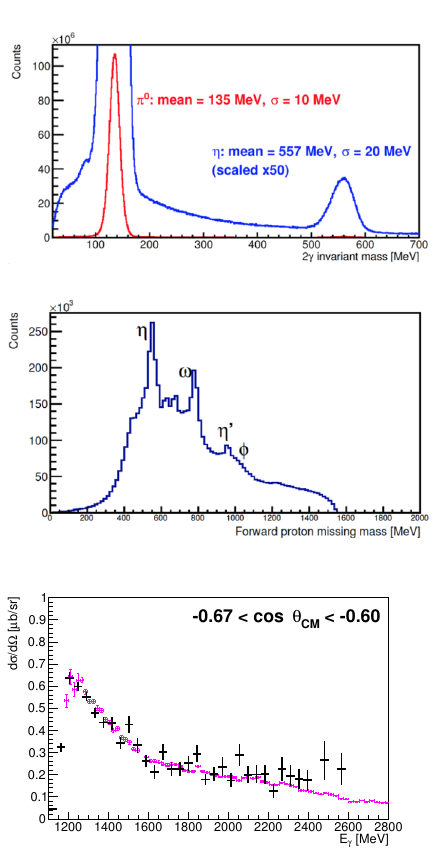
Figure 5. Preliminary di ff erential cross section of the reaction γ p → ω p for the ω cm angular bin inset. Black data is BGO-OD, in comparison to CLAS [19]